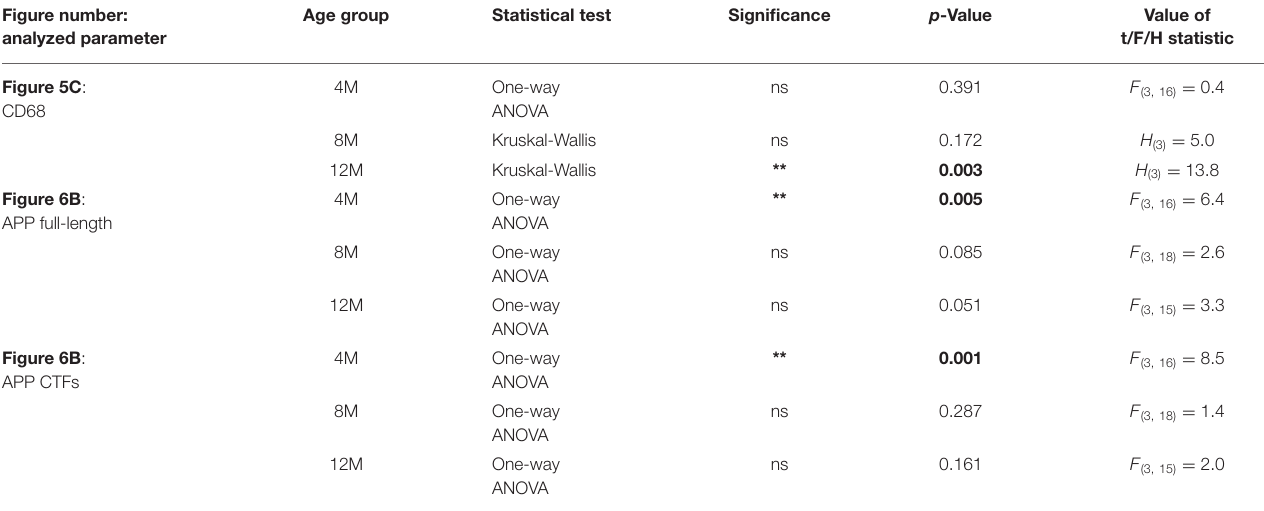
Figure number: analyzed parameter Figure 5C : CD68